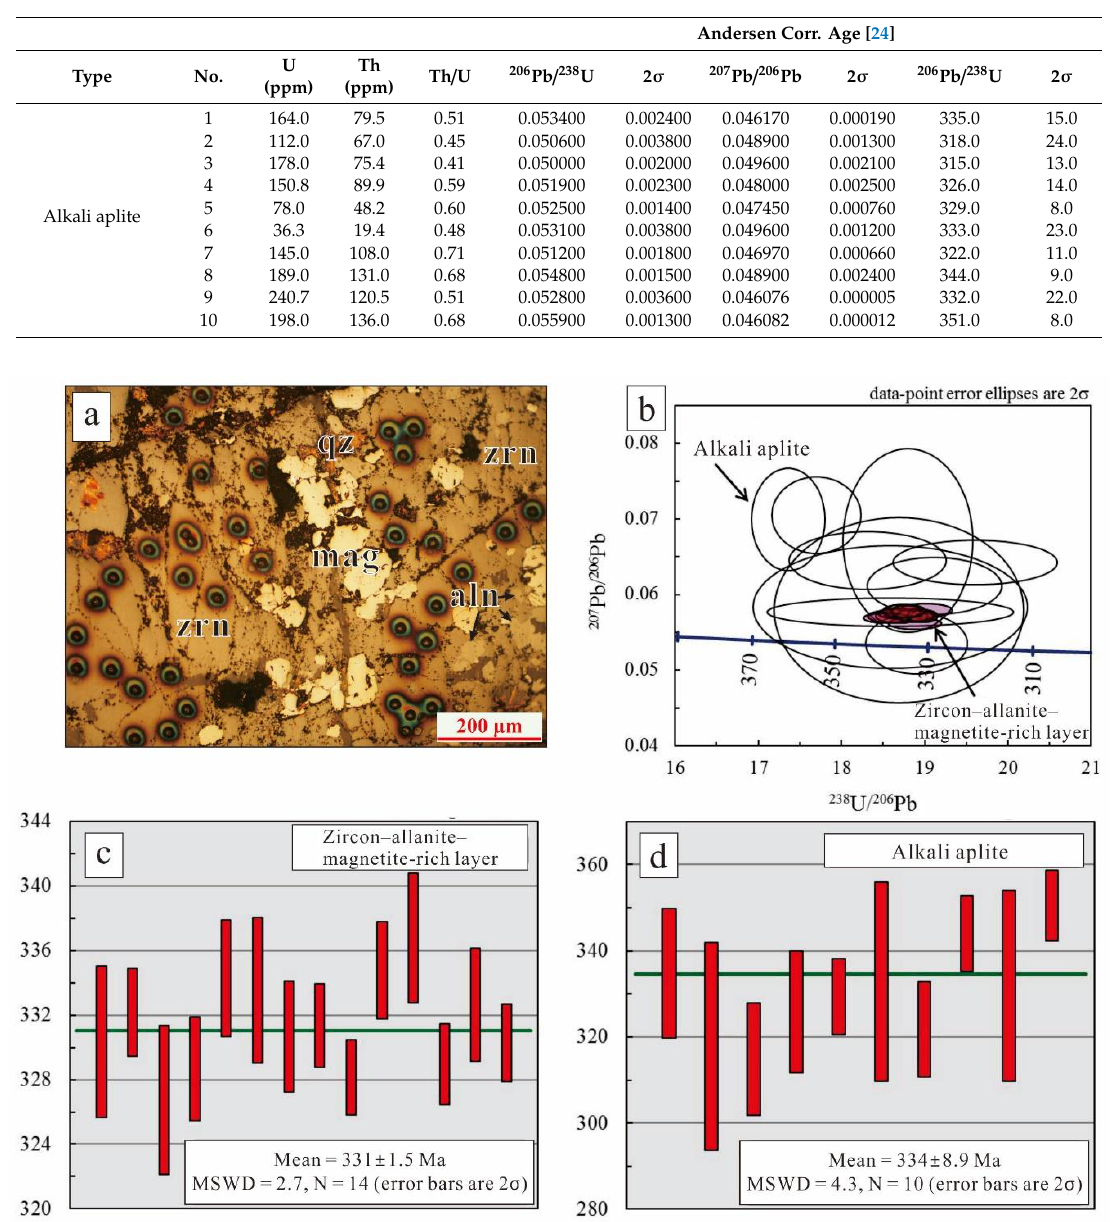
Figure 7. U–Pb isotope analyses. ( a ) Photomicrograph of zircon from a zircon–allanite–magnetite-rich layer. ( b ) Tera–Wasserburg Concordia diagram. The open circles mark alkali aplite, and the red ellipses mark zircon–allanite–magnetite-rich layers. ( c ) Weighted average zircon U–Pb